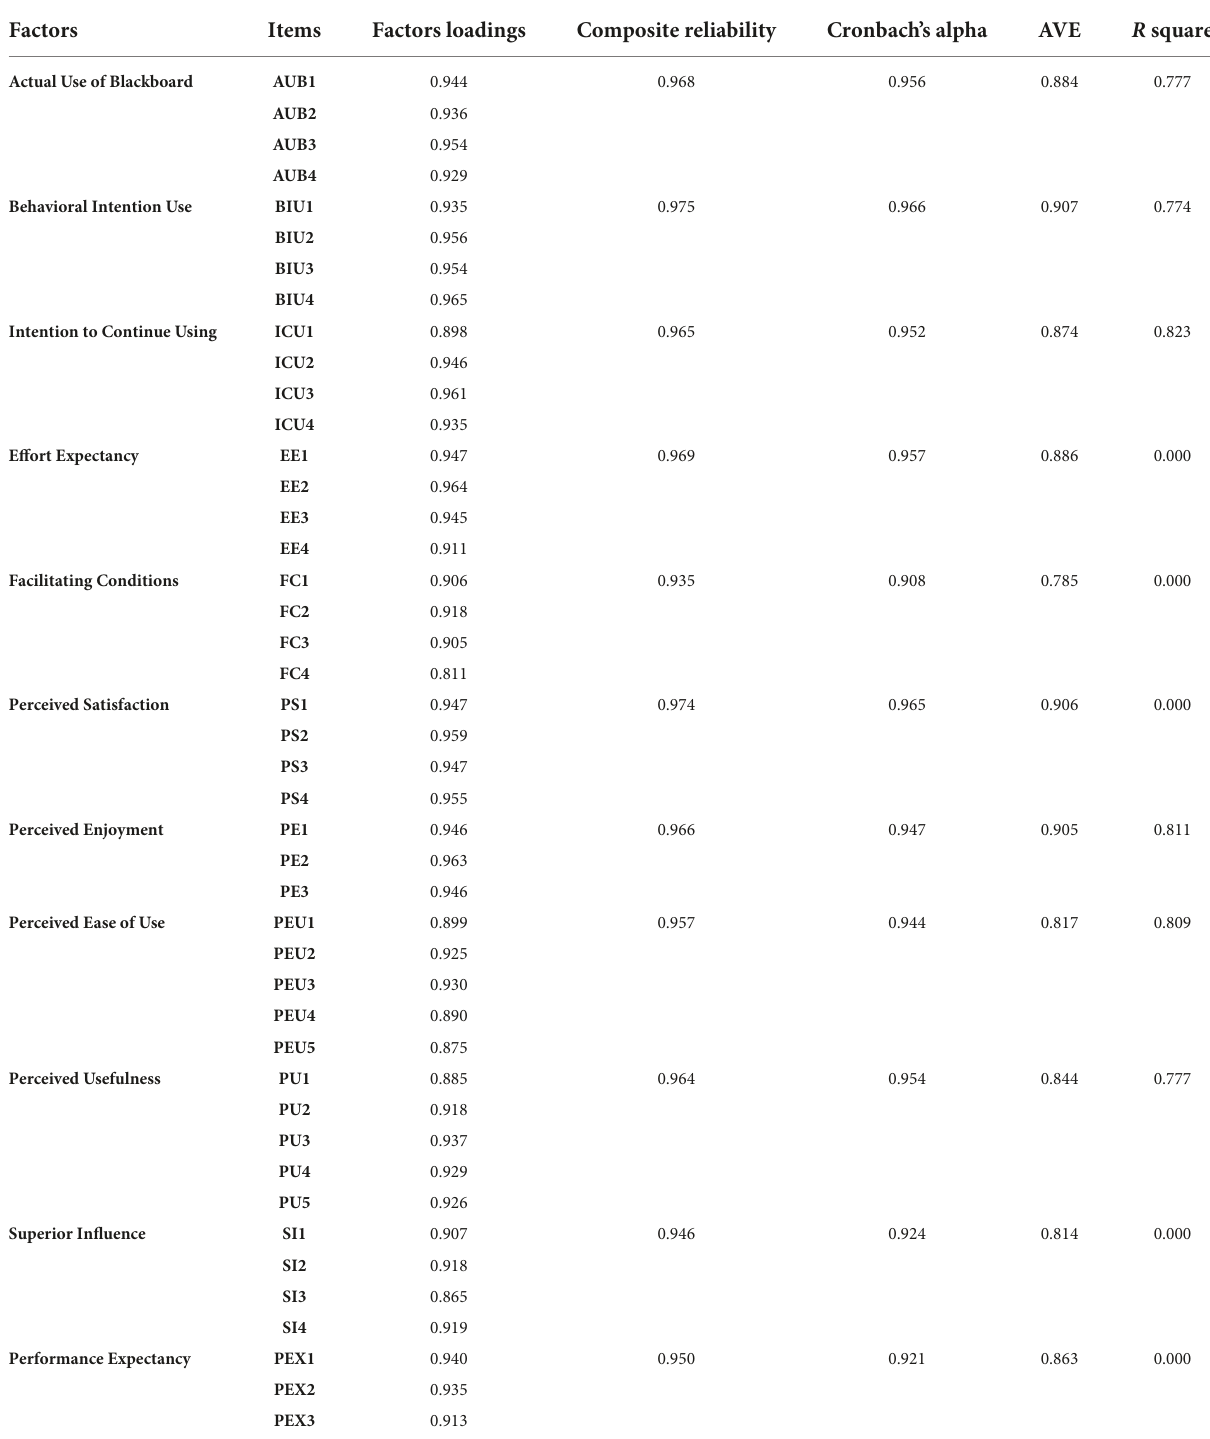
TABLE 3 Confirmatory factor